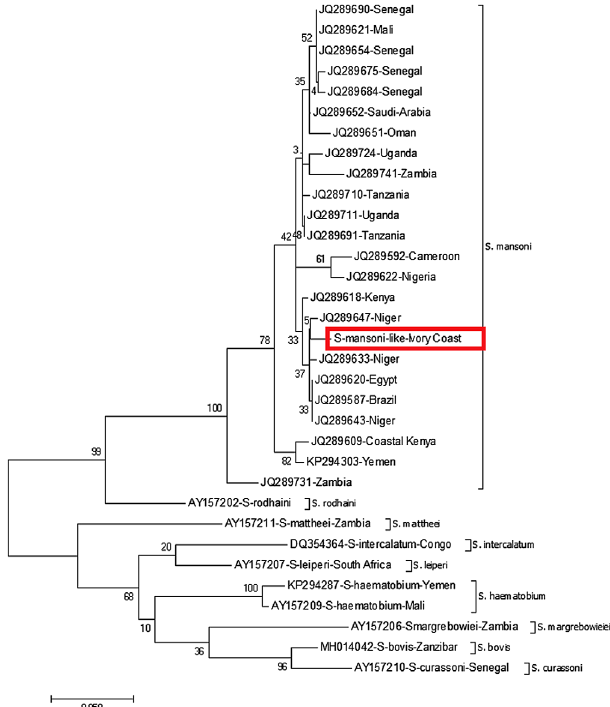
Figure 2. ML tree built on COI mtDNA sequences of Schistosoma spp. The percentage of trees in which the associated taxa clustered together is shown next to the branches. The tree is drawn to scale, with branch lengths measured in the number of substitutions per